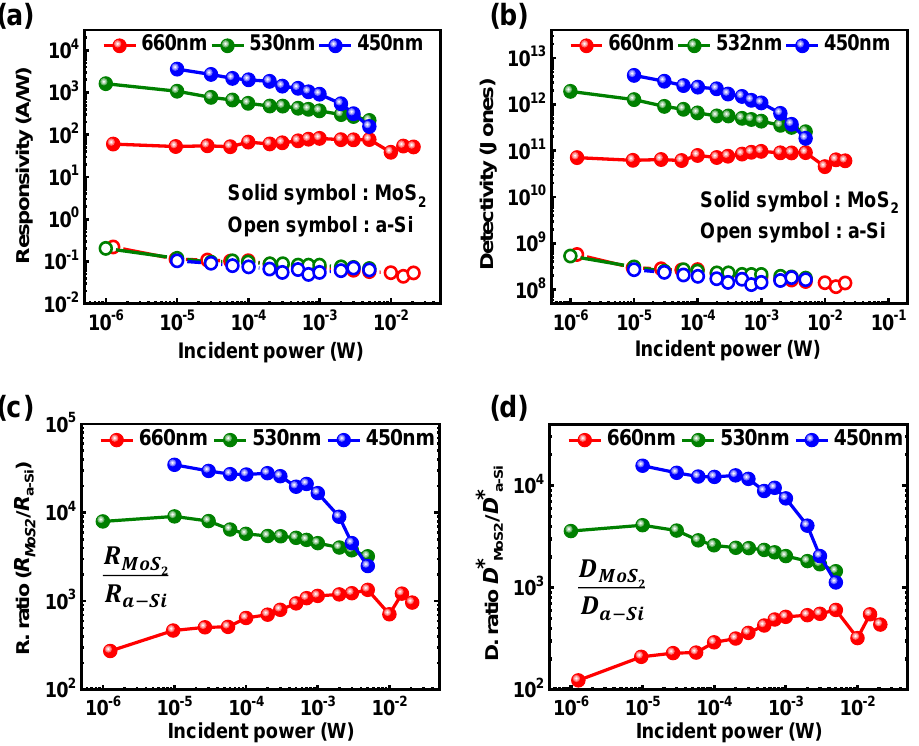
Figure 4. ( a ) Responsivities and ( b ) detectivities of a-Si:H and m-MoS 2 TFTs extracted from Figures 2 and 3. Directly compared ( c ) responsivities and ( d ) detectivities of a-Si:H and m-MoS 2 TFTs. The ratio was calculated from the values of the m-MoS 2 TFTs divided by those of the a-Si:H TFTs. In addition, as a circuit level photodetector, photosensitive inverters were imple- mented and compared using a-Si:H and m-MoS 2 TFTs in Figure 5. These photoinverters are key component of light-to-frequency conversion circuits (LFCs), which are practically